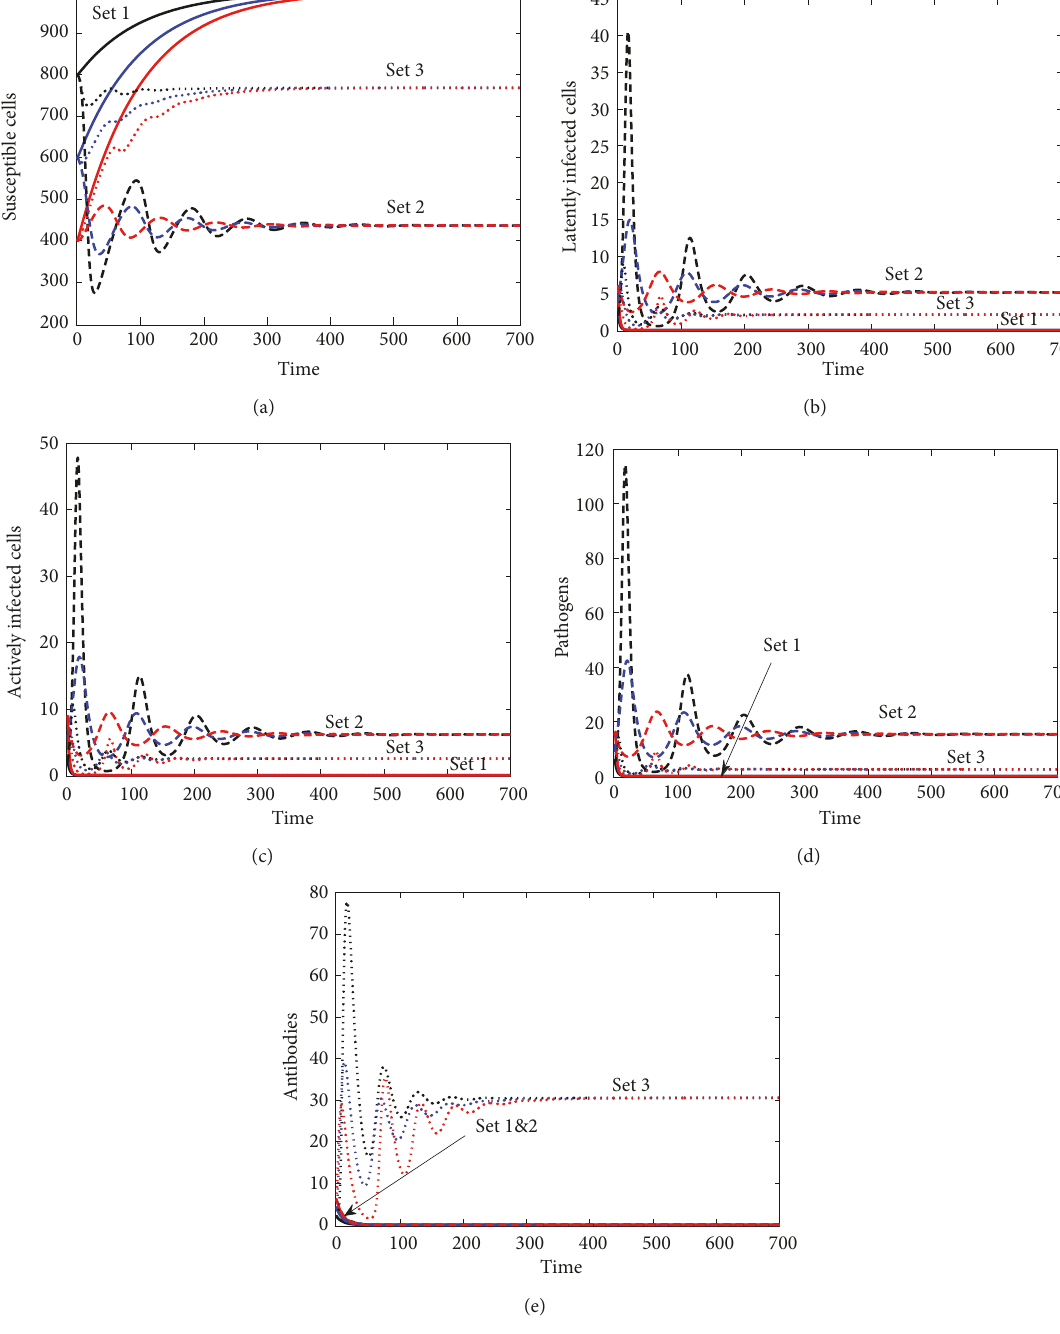
Figure 1: The evolution of system (69)-(73) for Case